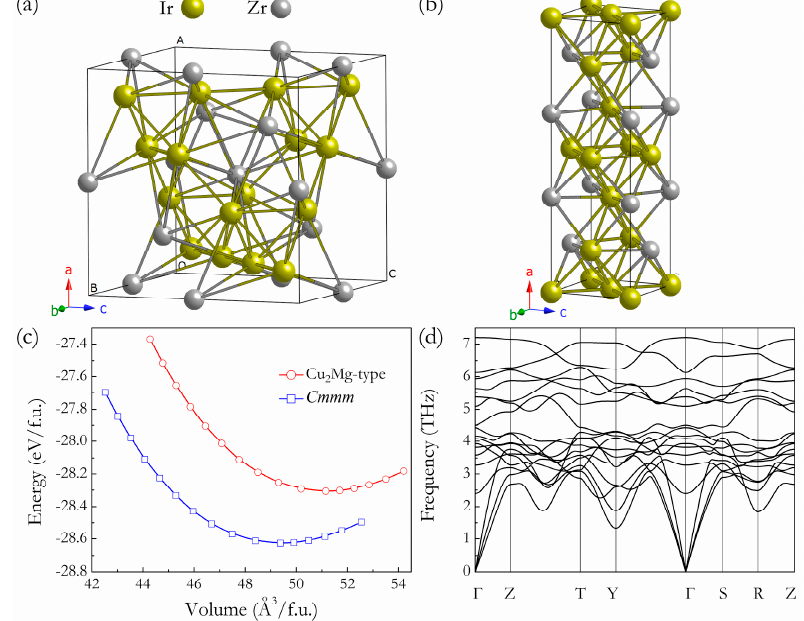
Figure 1. Crystal structures of Cu 2 Mg-Ir 2 Zr ( a ) and Cmmm -Ir 2 Zr ( b ), the large and small spheres represent Ir and Zr atoms, respectively. The total energy vs. f.u. volume for Cu 2 Mg-type and Cmmm structures ( c ) and phonon dispersion curves of Cmmm -Ir 2 Zr at 0 GPa ( d ).